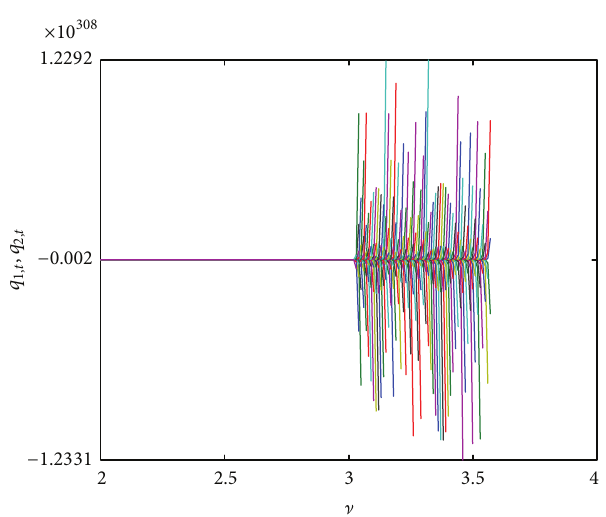
Figure 3: Behavior of 𝑞 1,𝑡 and 𝑞 2,𝑡 at the parameters: 𝑎 = 8 , 𝑐 = 2 , = 2.5 , 𝑞 = 0.5 , and 𝜂 = 1 . 𝑏 = 1 , 𝑞 0,1 0,2